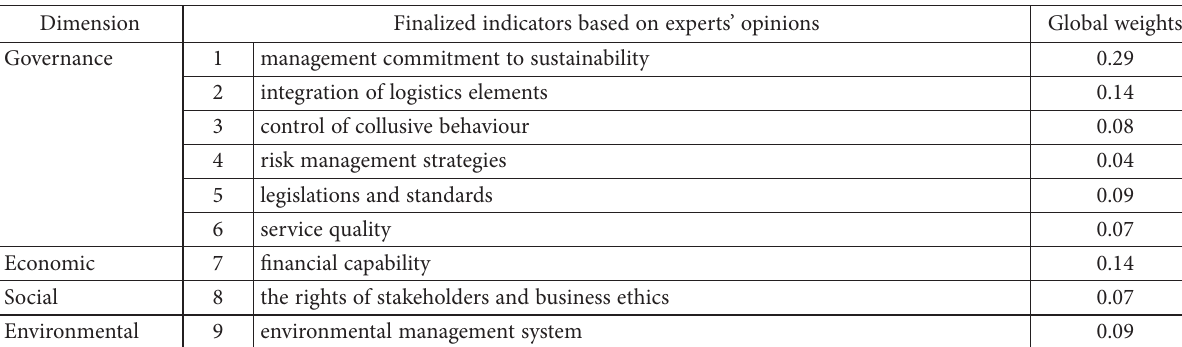
Table 5. Finalized indicators based on experts’ opinions and their